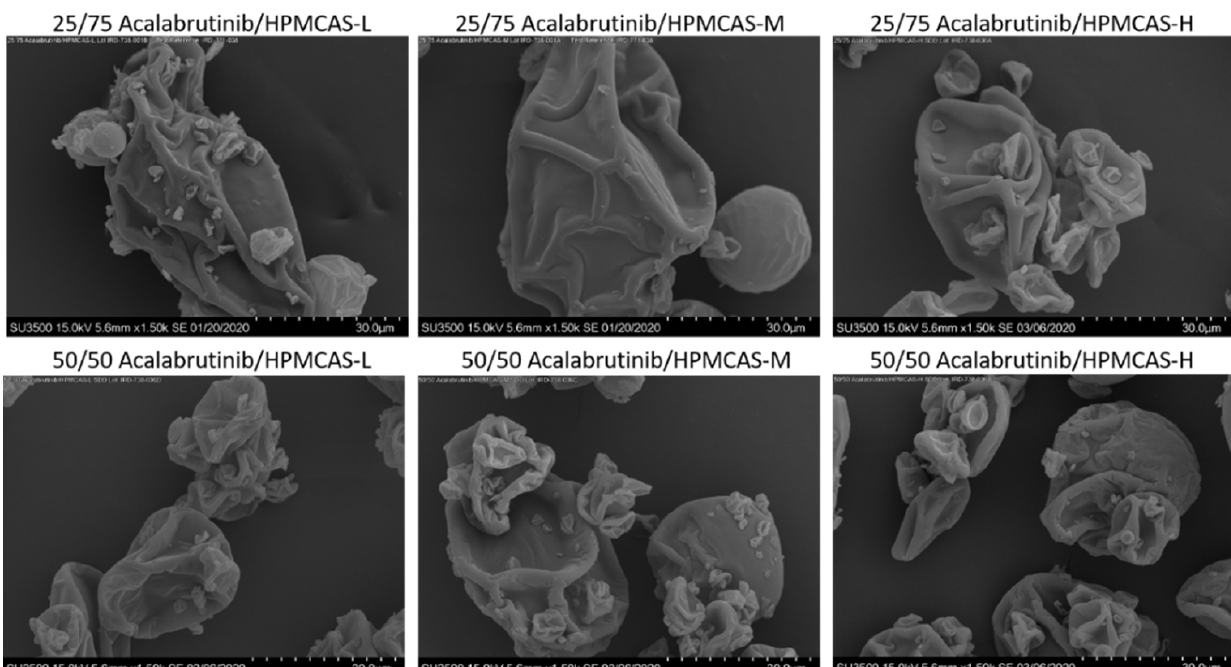
Figure A3. Scanning electron microscopy images of manufactured acalabrutinib ASDs.